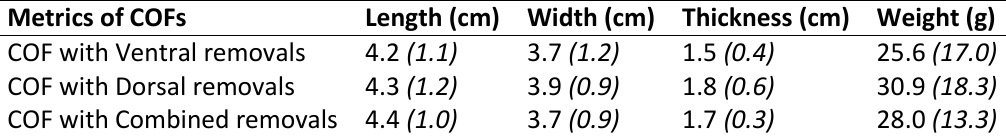
Table 1: Metrics of COFs. Average values with standard deviation in parentheses.